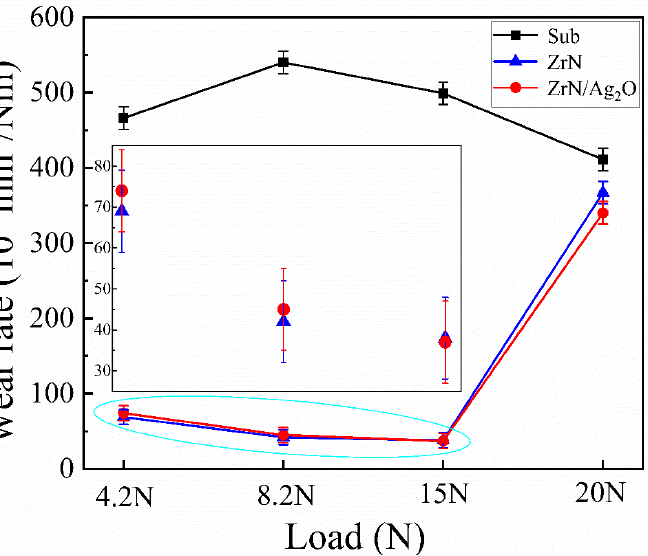
Figure 5. ( a ) Micro-hardness of substrate, separate ZrN coating and ZrN/Ag 2 O composite coatings; ( b ) the scratched scar image, the corresponding acoustic emission spectra and penetration depth of ZrN/Ag 2 O composite coating.